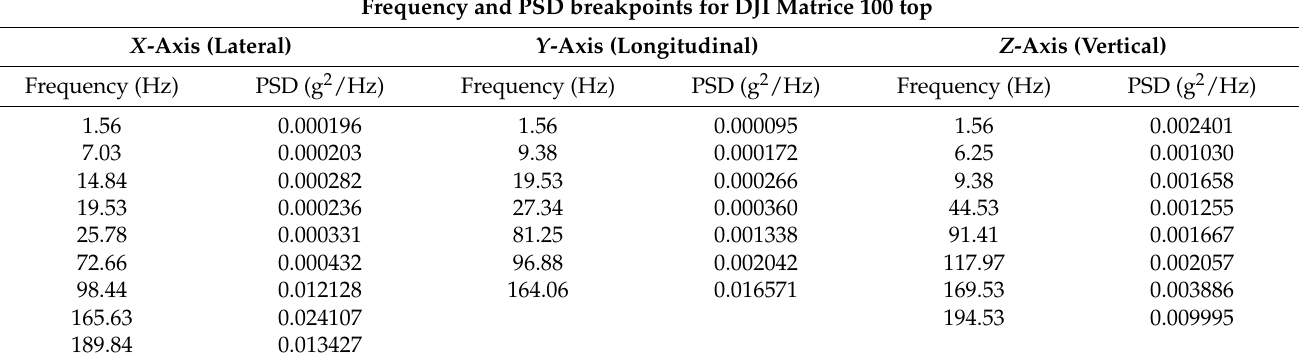
Table 4. Frequencies and PSD breakpoints for DJI Matrice